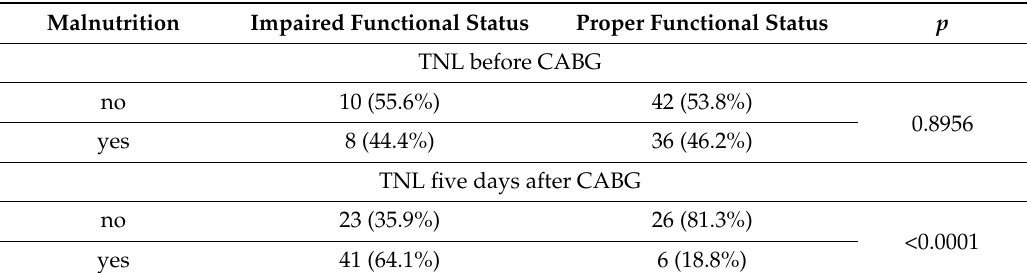
Table 8. Relationship between the state of malnutrition (TNL) and the level of patients’ independent functional status (ADL).